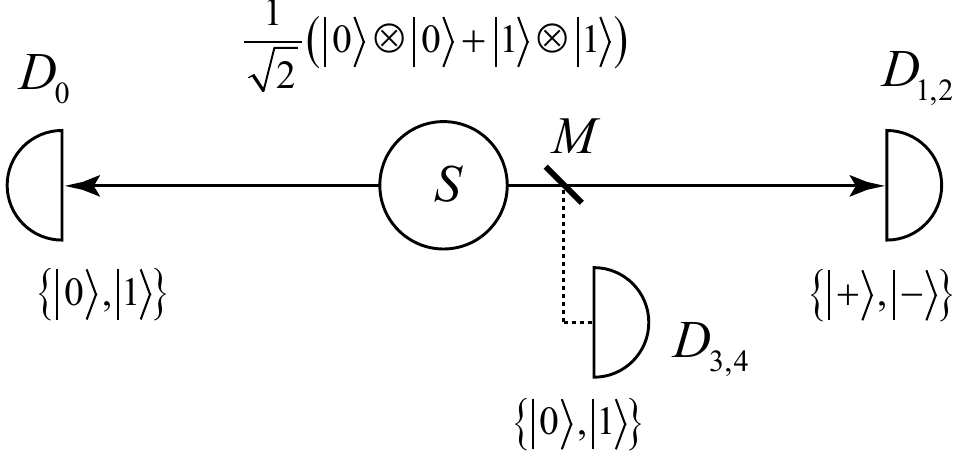
Figure 1: A Bell-type experiment resembles the delayed choice quantum eraser